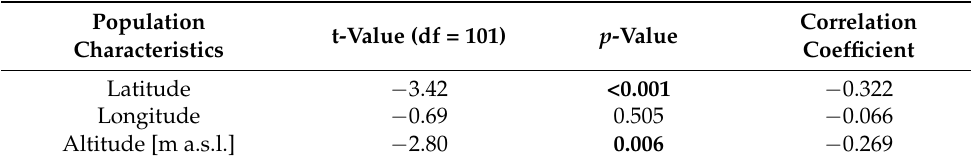
Table 1. Pearson’s correlation with corresponding p -values (significant values in bold) for population distribution data (latitude, longitude, and altitude) and mean population genome sizes (2C-values) for Anthoxanthum odoratum